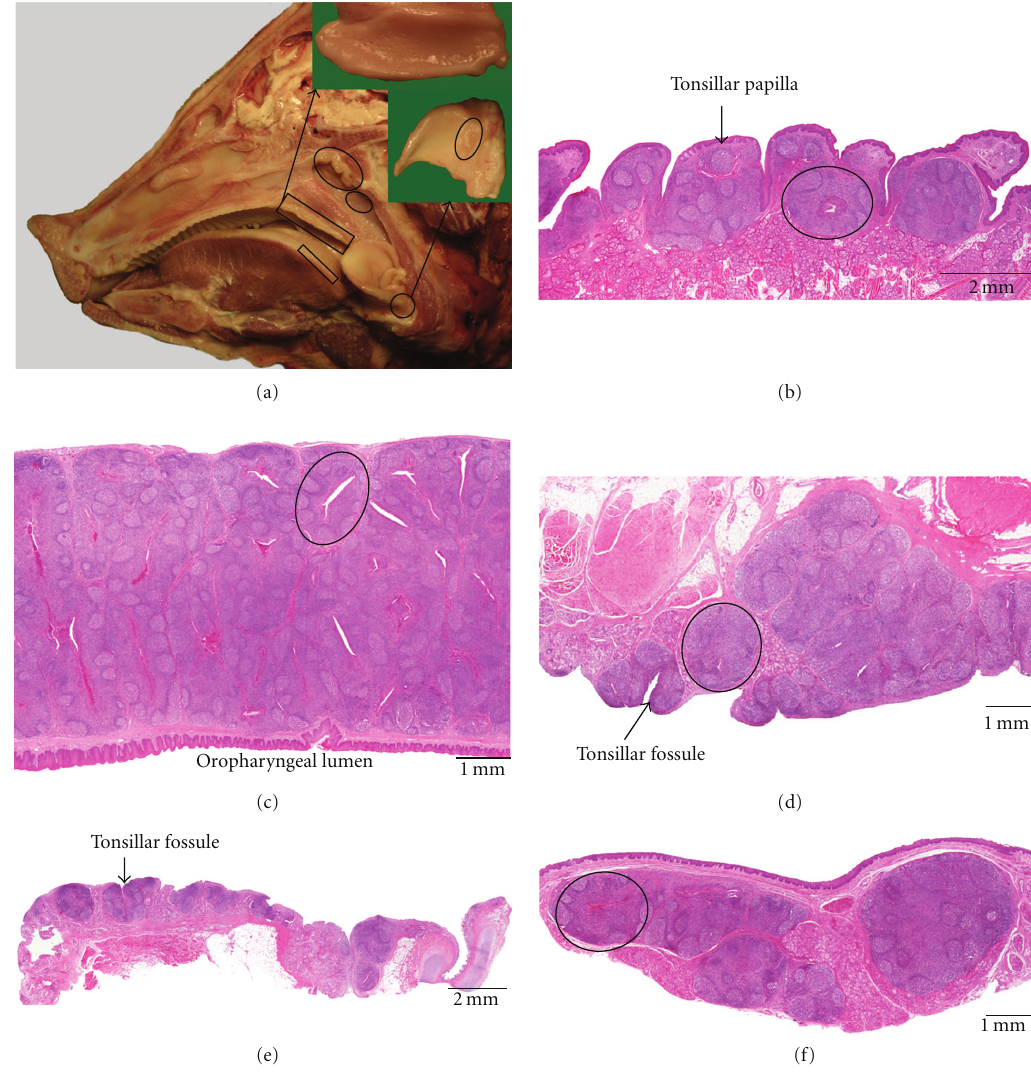
Figure 4: Anatomical localization and histological characteristics of the porcine tonsils. (a) Median section through a porcine head. The pharyngeal tonsil (large oval area) and tubal tonsil (small oval area) in the nasopharynx, the tonsil of the soft palate at the oral side of the soft palate (larger rectangular area, detail shown in upper right insert), and the lingual tonsil (smaller rectangular area) and the paraepiglottic tonsil at the lateral base of the epiglottis (encircled area, detail shown in the lower right insert) are indicated. (b–f) Histological sections through parts of the lingual tonsil (b), the tonsil of the soft palate (c), the pharyngeal tonsil (d), the tubal tonsil (e), and the paraepiglottic tonsil (f), respectively. The encircled areas in (c), (d), and (f) delineate a tonsillar follicle with a central